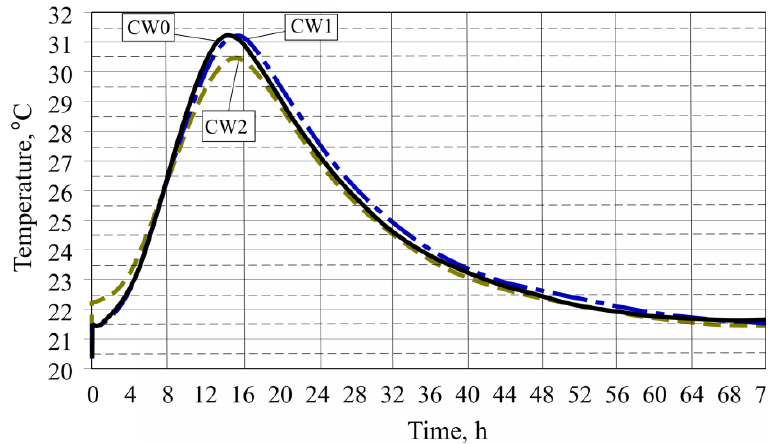
Figure 5. Dependence of the variation of exothermic effect temperatures on the amount of concrete waste during the hardening process. Table 3. Results of exothermic e ff ects. Table 3. Results of exothermic effects.